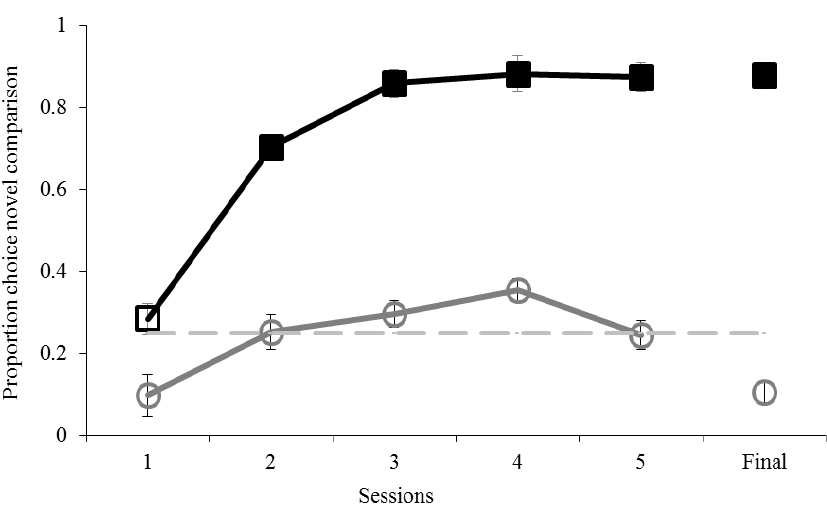
Figure 3. Proportion choice of the novel comparison image on exclusion (black) and baseline (solid grey) trials on the first five and the final session of testing. Dashed line indicates chance level. Filled data markers indicate above chance performance, open data markers indicate chance performance. Error bars indicate standard